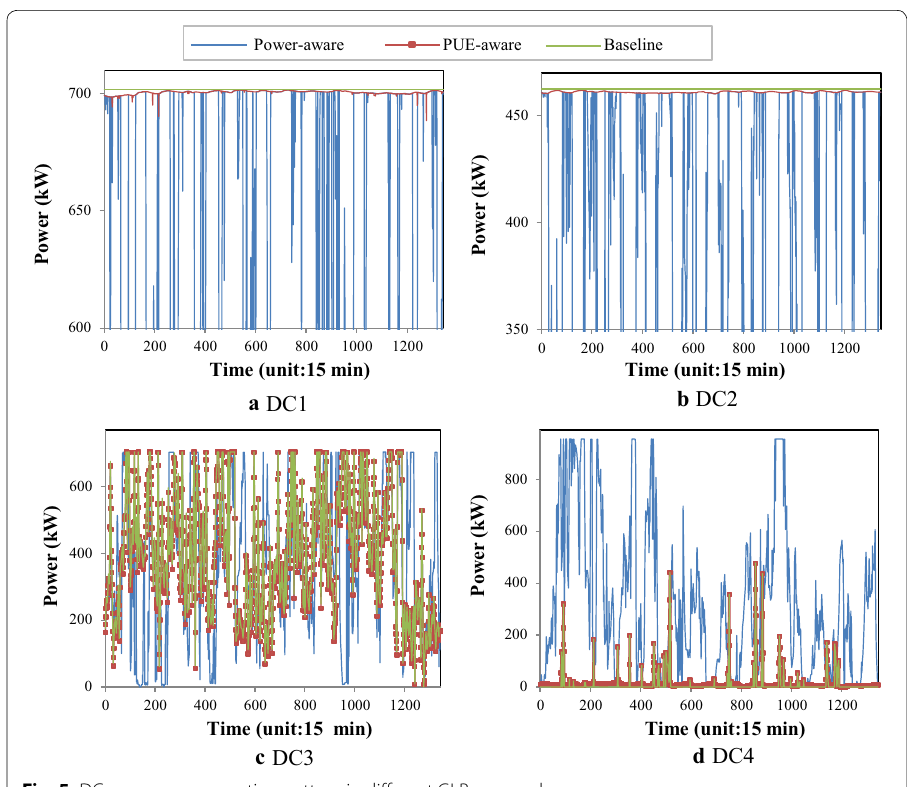
Fig. 5 DCs power consumption pattern in different GLB